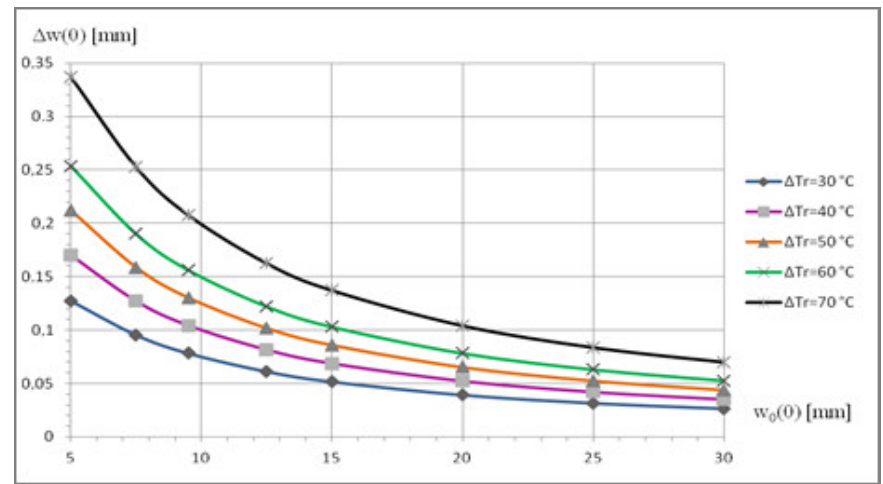
Figure 14. Additional deflection (∆w(0)) for the AE made of titanium alloy with 160 mm diameter as a function of its initially designed deflection (w 0 (0)).